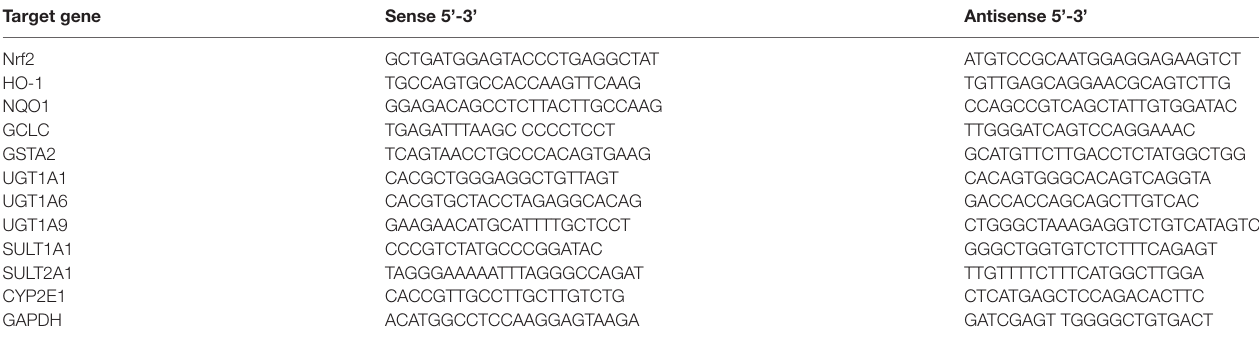
TABLE 1 | Primers used for quantitative real-time PCR. Target